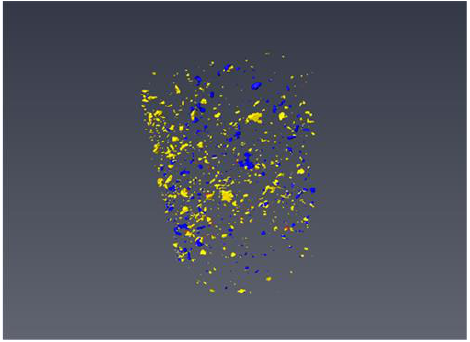
Figure 7. CT scanning distribution of the oil (residual oil), gas (CO 2 ), and water (yellow is gas, red is residual oil, and blue is irreducible water).